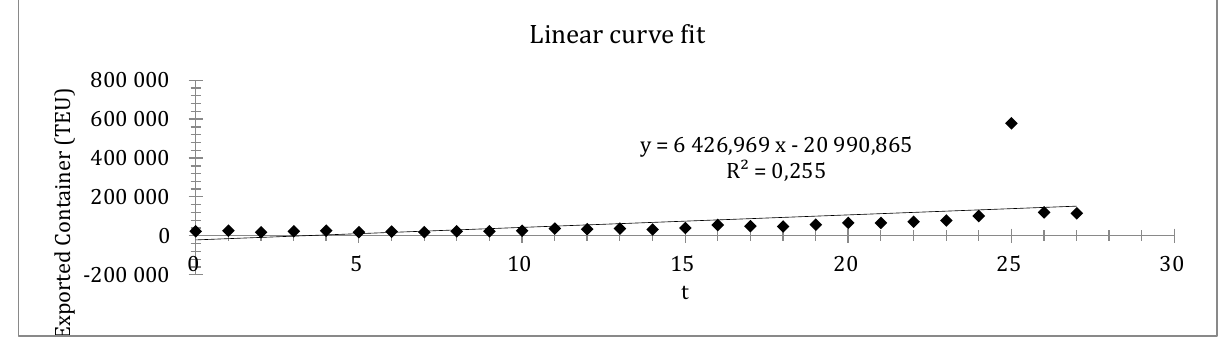
Figure 3: Linear curve fit for the trend analysis for exported container traffic in Nigeria (1999-2017) Linear curve